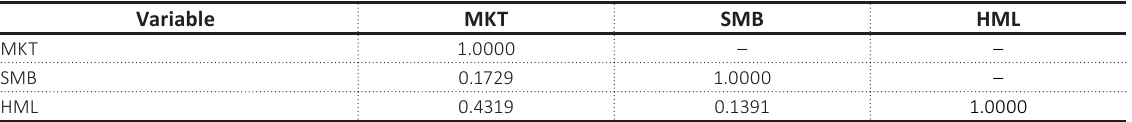
Table A3. Measure of correlation between the factor portfolios Source: Calculated by the authors based on the data available on Prowess IQ database.